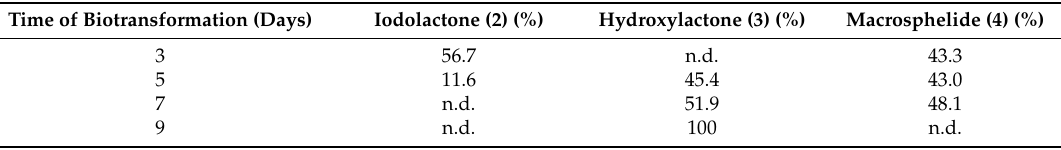
Table 3. The results obtained with iodolactone 2 addition in stationary phase of growth (according to